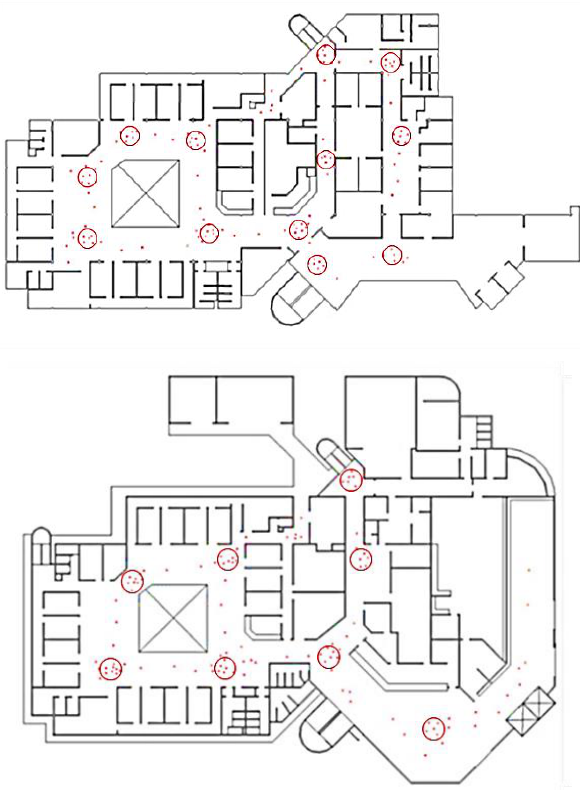
Figure 11. Illustration of the location of the map calls mapped on the building layout of the 1st VRE.